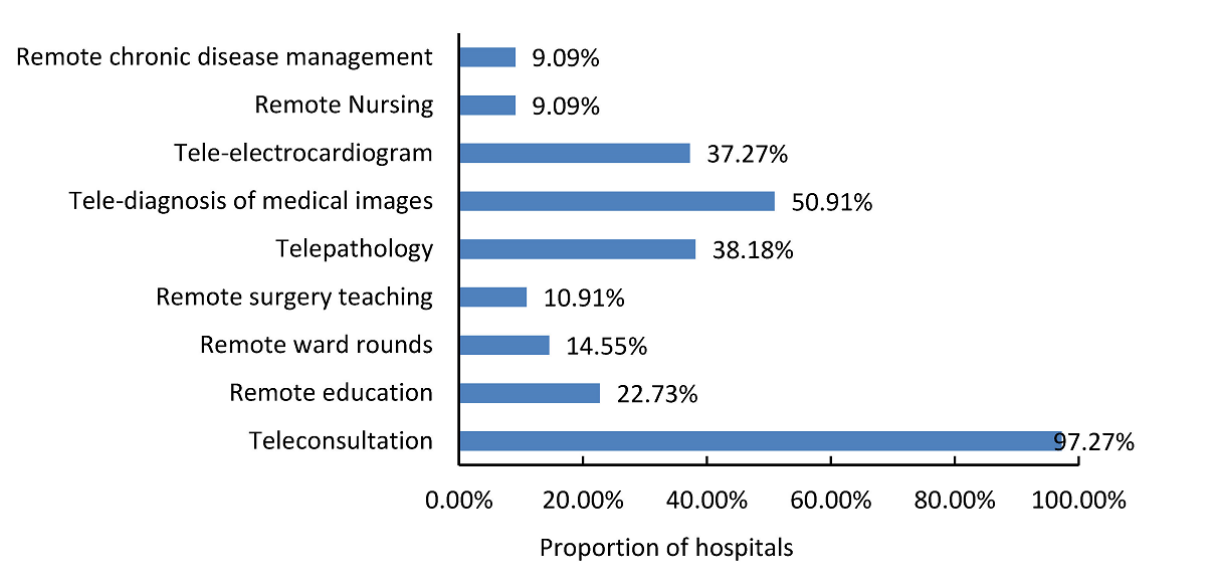
Figure 7. Proportion of hospitals charging for different telemedicine